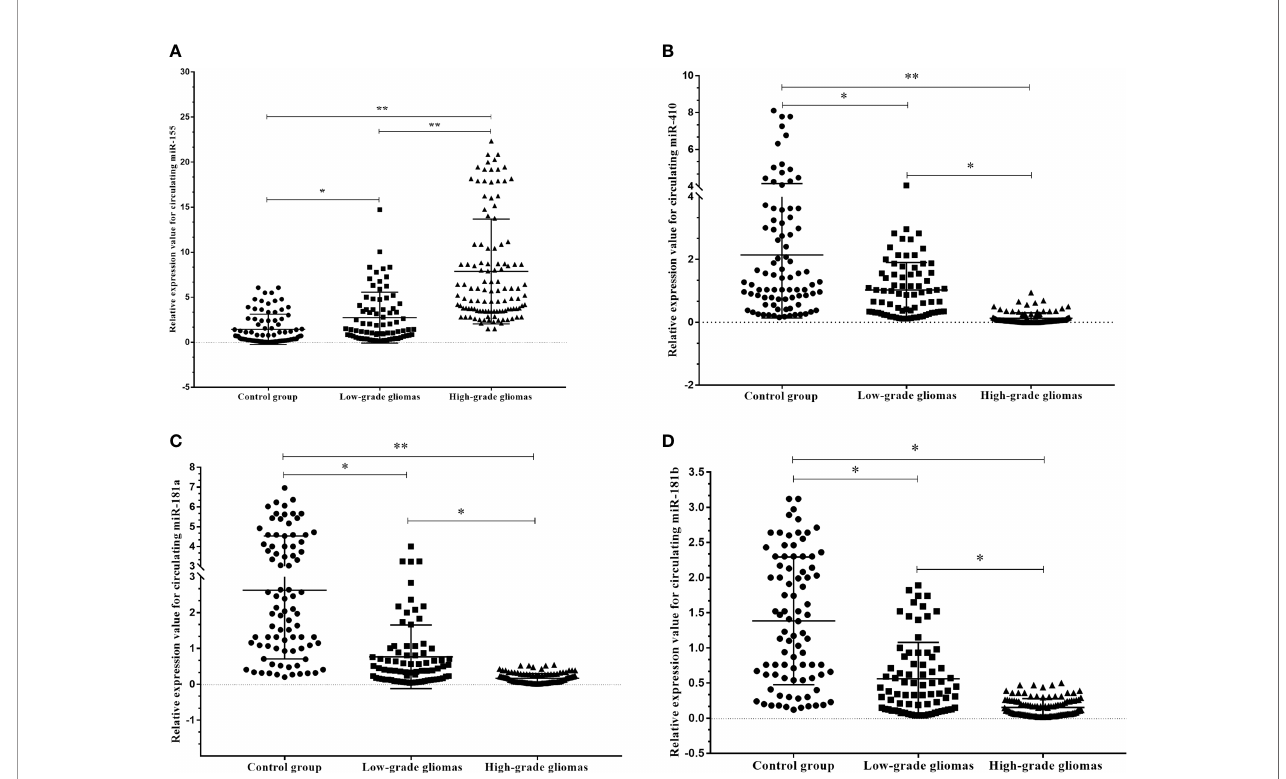
FIGURE 4 | Circulating miR-181a/b, miR-410 and miR-155 expression levels within different grade gliomas and control group (A – D) . (A) The expression levels of circulating miR-155 in the plasma of high-grade glioma patients were signi fi cantly higher than in low-grade glioma patients and control group. In the same time, (B – D) the expression levels of circulating miR-181a, miR-181b and miR-410 in the plasma of high-grade glioma patients were signi fi cantly lower than in low-grade glioma patients and control group. A probability of p < 0.05 (*) or p < 0.001 (**) was considered statistically signi fi